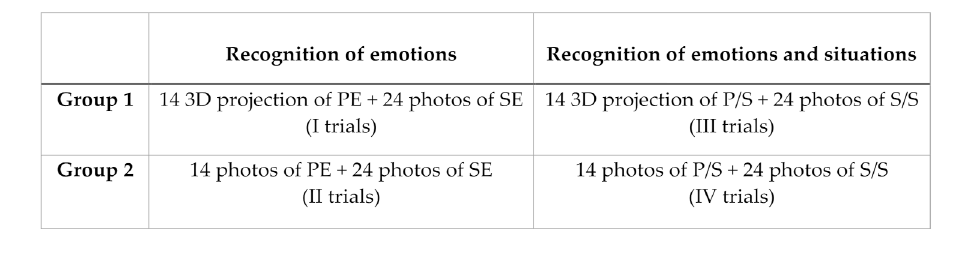
Figure 1. Description of